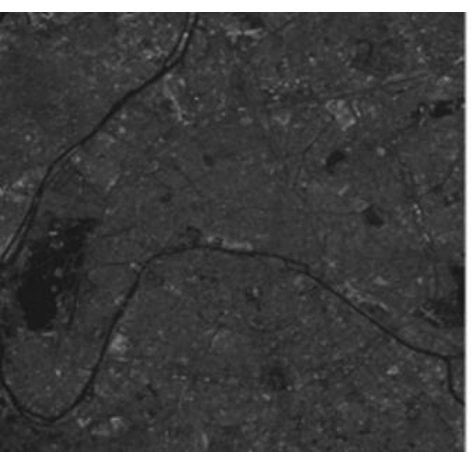
Figure 9. The image of the analyzed area is in the visible red